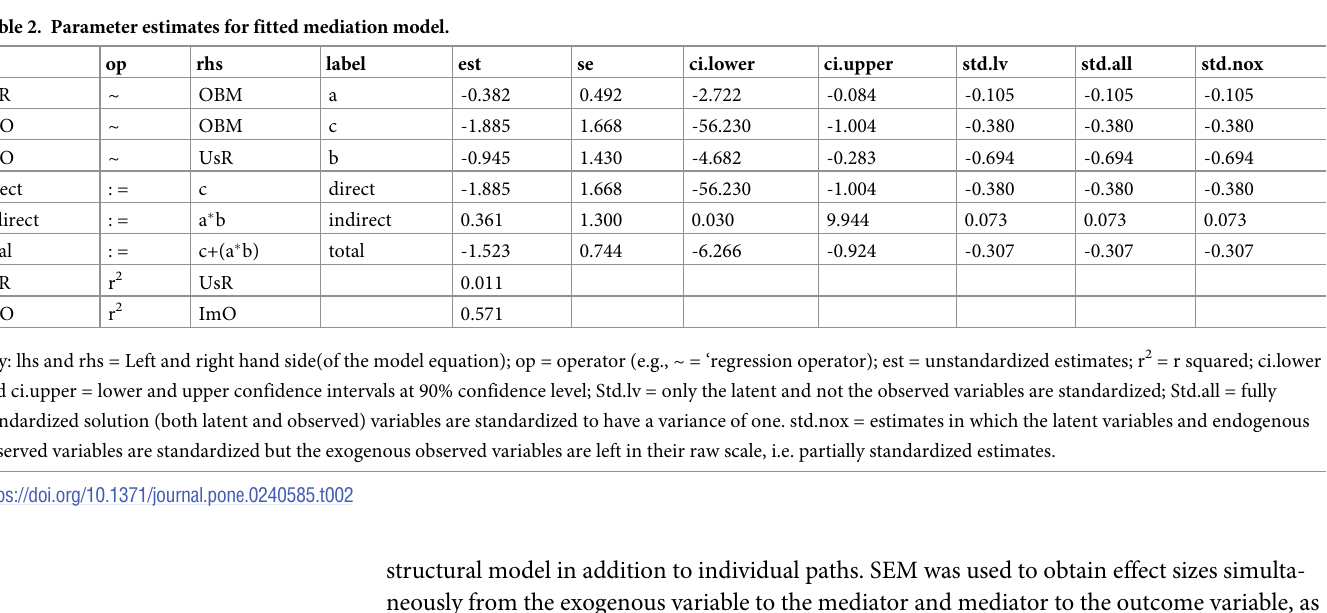
Table 2. Parameter estimates for fitted mediation model.